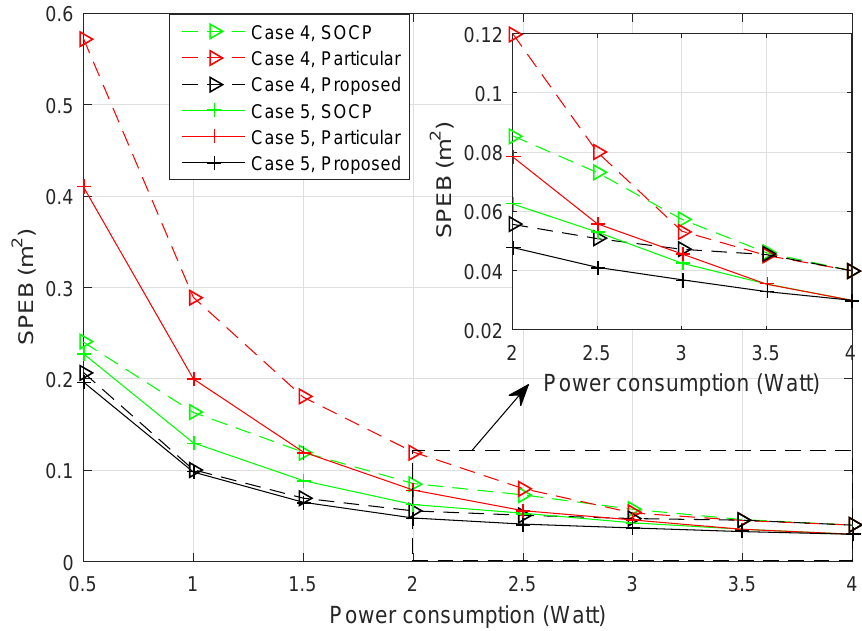
Figure 11. The average SPEB of agent nodes with respect to total power consumption of anchor nodes. SOCP, second-order cone